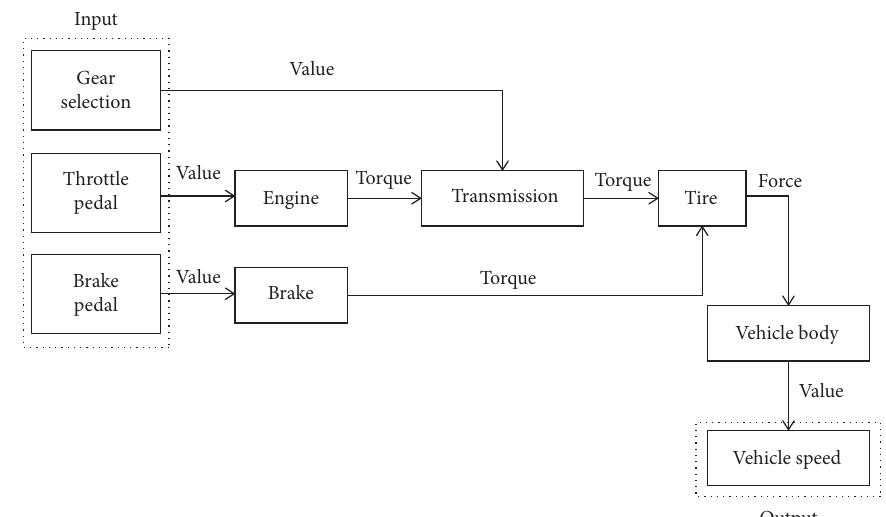
Figure 2: Architecture of the established vehicle